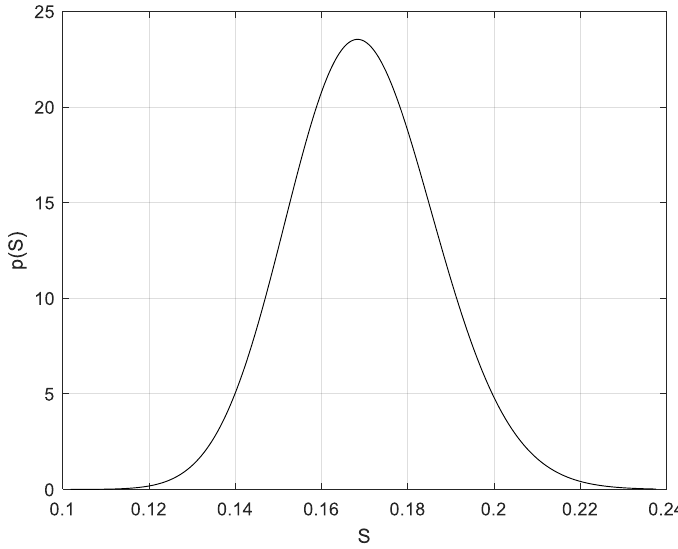
Figure 6. Beta prior PDF for S in case C’22 (S has mean value 0.1697 and CV = 0.10, implying the parameter values: r = 82.86, s = 405.4).